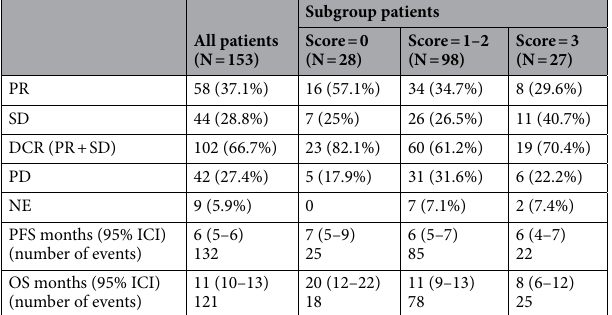
Table 3. Best response, PFS and OS according to score population. Number (N); partial response (PR); stable disease (SD); disease control rate (DCR); progression disease (PD); not evaluable (NE); mMedian (median); progression free survival (PFS); overall survival (OS); confidence interval (CI).